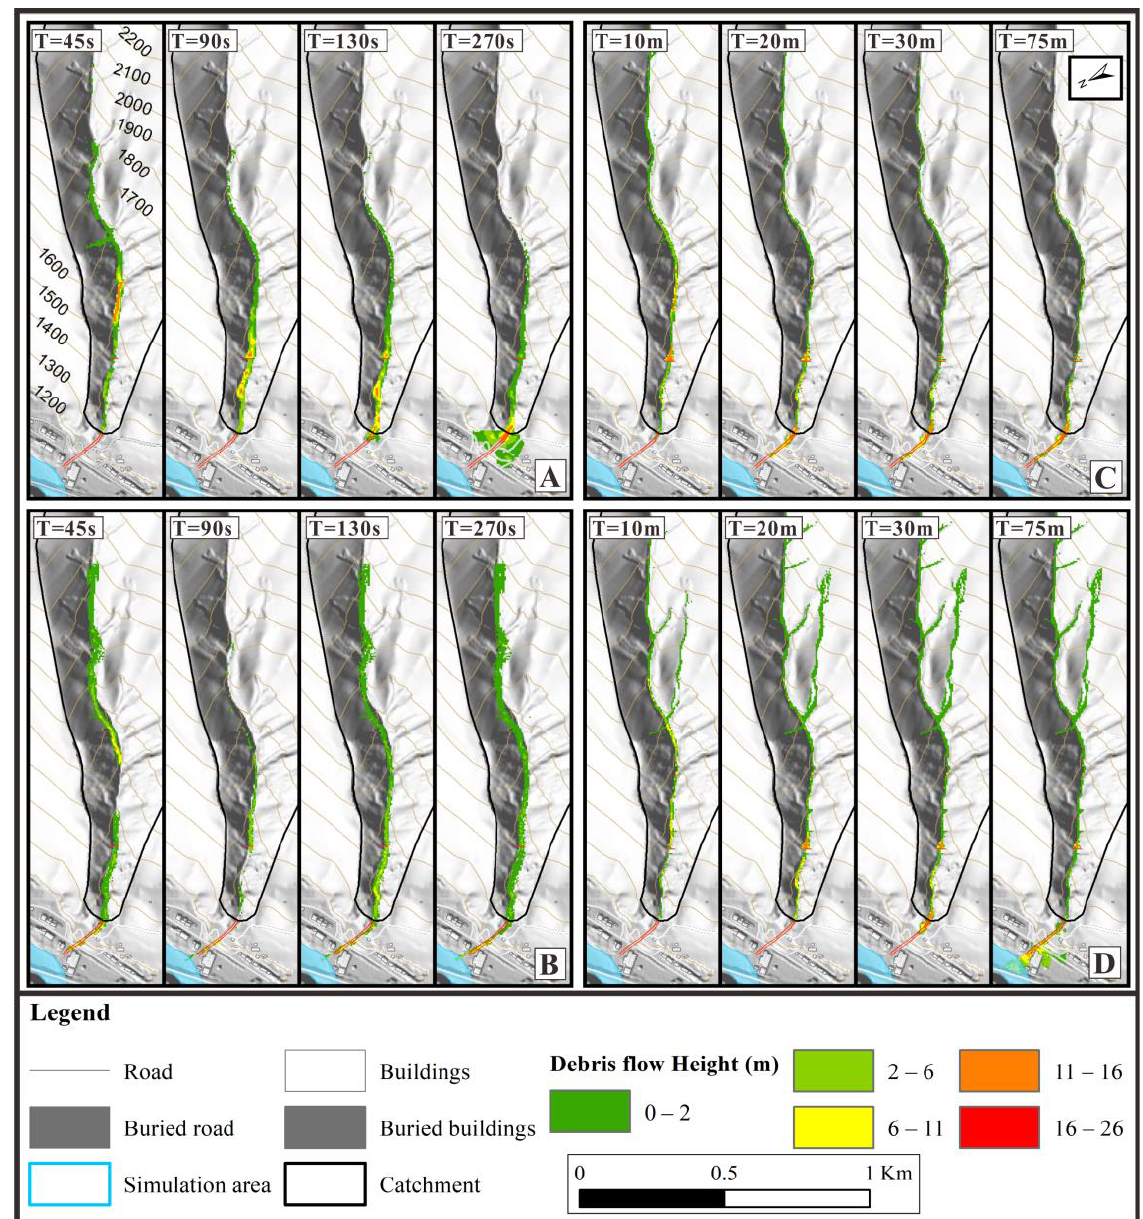
Figure 12. Snapshots of the debris flow height of Wayao debris flow in 2020 simulated by Massflow ( A ), Flow-3D ( B ), OpenLISEM_A ( C ), and OpenLISEM_B ( D ). Abbreviations: s means seconds, and m means minutes.